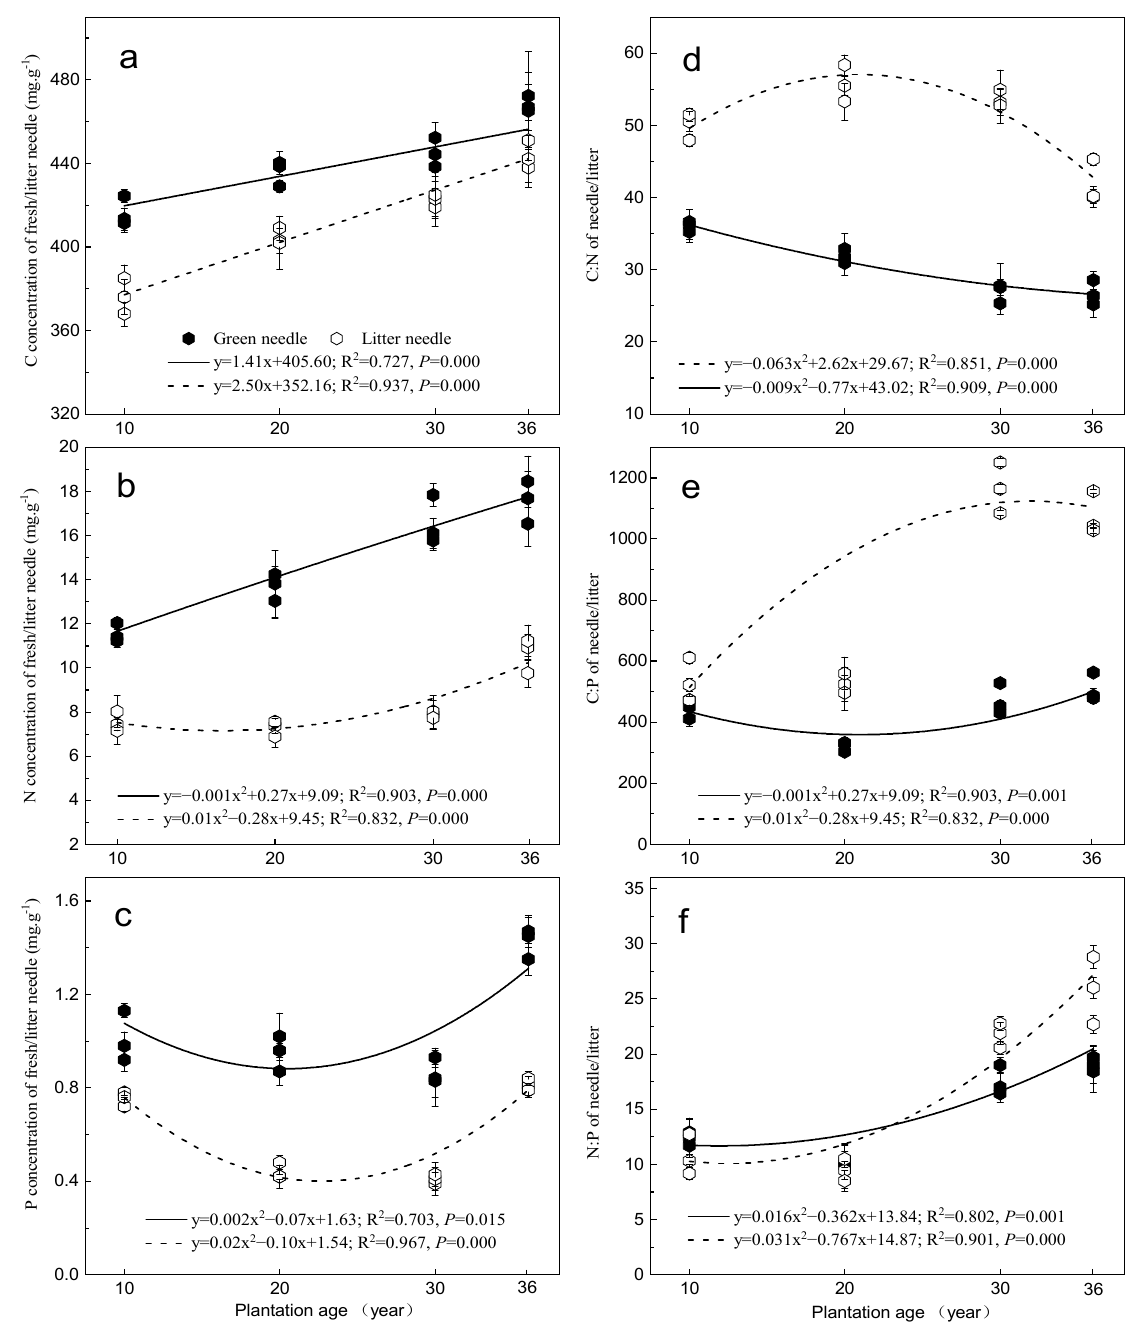
Figure 2. Fresh and senesced needles’ C, N, and P concentrations ( a – c ) and their stoichiometry ratios ( d – f ) along the chronosequence of P. massoniana plantations.